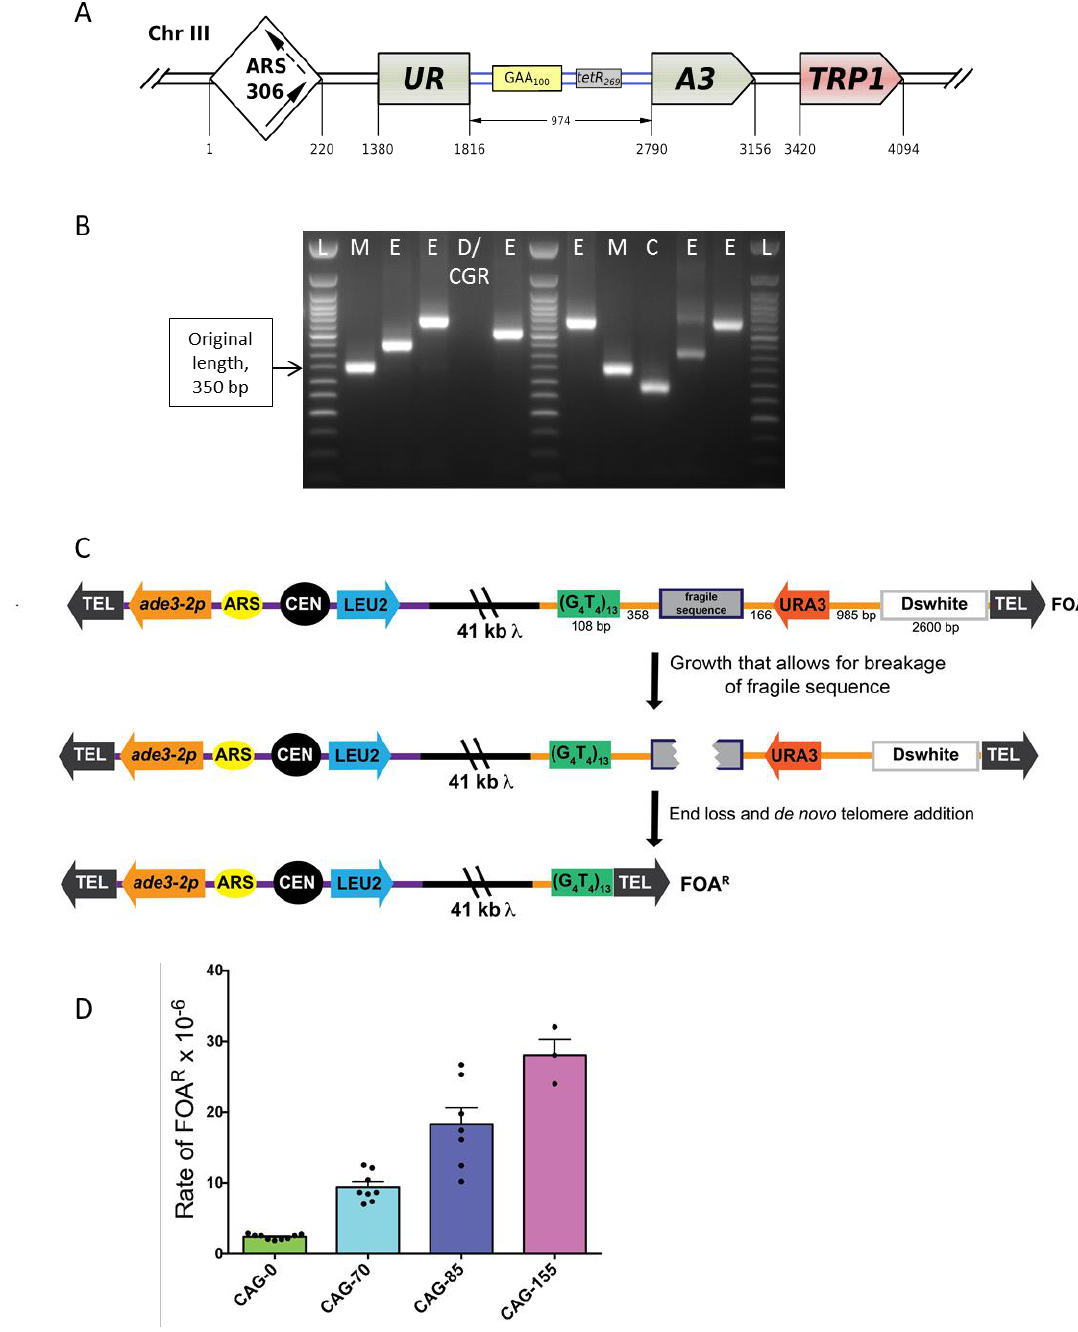
FIGURE 6: Scheme of the genetically tractable systems to study repeat expansions and repeat-mediated genome instability in yeast. (A) Scheme of the genetically tractable system to study repeat expansions and repeat-mediated genome instability in yeast. The selectable cassette contains flanking sequences from chromosome III, the URA3 gene from the pYES2 plasmid (Invitrogen) (green), an intron sequence derived from the ACT1 gene from chromosome VI (inside the URA3 gene) (blue), part of the tetR coding region from the pACY184 plasmid (NEB) (gray), and the TRP1 gene from the pYES3/CT plasmid (Invitrogen) (red). (B) Gel electrophoresis of the PCR analysis of 5-FOA r colonies derived from a fluctuation test of a strain with 100 GAA repeats. L – ladder, M – mutation, E – expansion, D/CGR – deletion or CGR (complex genomic rearrangements), C – contraction with simultaneous repeat-mediated mutagenesis. The black arrow indicates a ~350bp PCR fragment of the original (GAA) 100 repeat. (C) Assay to measure chromosome fragility. In this system, a fragile sequence has been integrated onto a yeast artificial chromosome (YAC) between a telomere seed sequence (G 4 T 4 ) 13 and the URA3 gene. Breaks that occur within the fragile sequence are subject to resection and telomere addition at the G 4 T 4 sequence, which results in loss of the URA3 gene and renders cells 5-FOA R . The YAC additionally contains a LEU2 marker gene, which allows for maintenance of the YAC, a centromere (CEN4), an origin of replication (ARS1), yeast telomeres (TEL), a partially functional ade3-2p allele, and the Drosophila white gene. The orange line indicates pYIP5 plasmid backbone, the black line indicates lambda DNA, and the purple line corresponds to pUC18 plasmid backbone. (D) Wild-type fragility data of S. cerevisiae strain BY4705 where the fragile sequence integrated between the G 4 T 4 and URA3 marker is a CAG tract of the indicated length, in number of repeats. Assays done with this (CAG)n-URA3 YAC show that 5-FOA resistance increases with increasing number of CAG repeats. Data sourced from [107, 117, OPEN ACCESS | www.microbialcell.com Microbial Cell | JANUARY 2019 | Vol. 6 No. 1